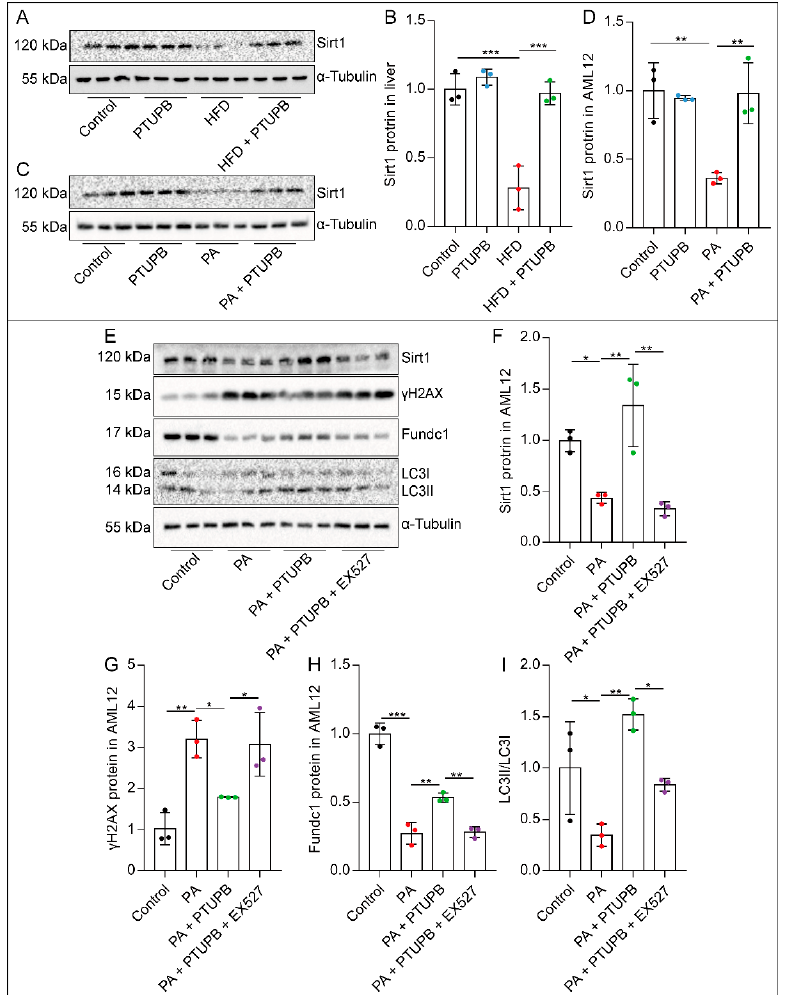
Figure 6. PTUPB enhances hepatocyte autophagy by promoting Sirt1 expression. The protein expressions of Sirt1 in the liver (( A , B ), n = 6) and AML12 cells (( C , D ), n = 3) were measured by Western blot and quantitatively analyzed. Cells were treated with PTUPB (1 µ M) or EX527 (10 µ M) for 1 h before treatment with PA (200 µ M) for 48 h. The protein expressions of Sirt1, γ H2AX, Fundc1, and LC3II/I in AML12 cells were measured by Western blot and quantitatively analyzed (( E – I ), n = 3). Data are expressed as the mean ± SD. Differences among multiple groups were performed using ANOVA. Tukey’s test was used as a post hoc test for pairwise comparisons. * p < 0.05, ** p < 0.01, and *** p <